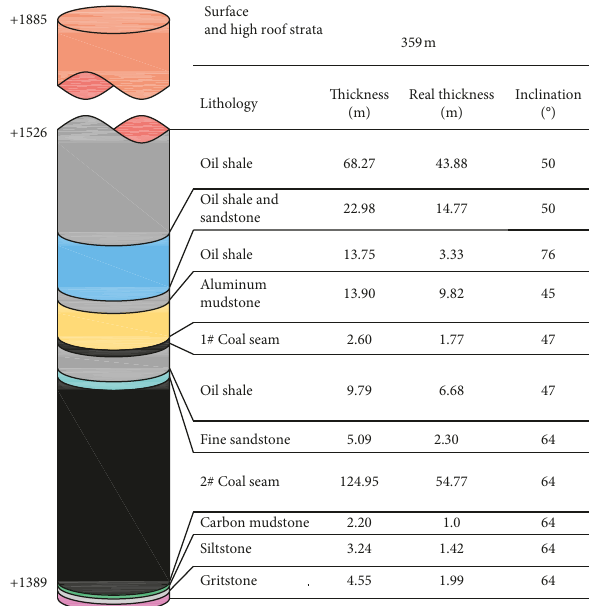
Figure 11: Histogram of 527# prospecting hole.